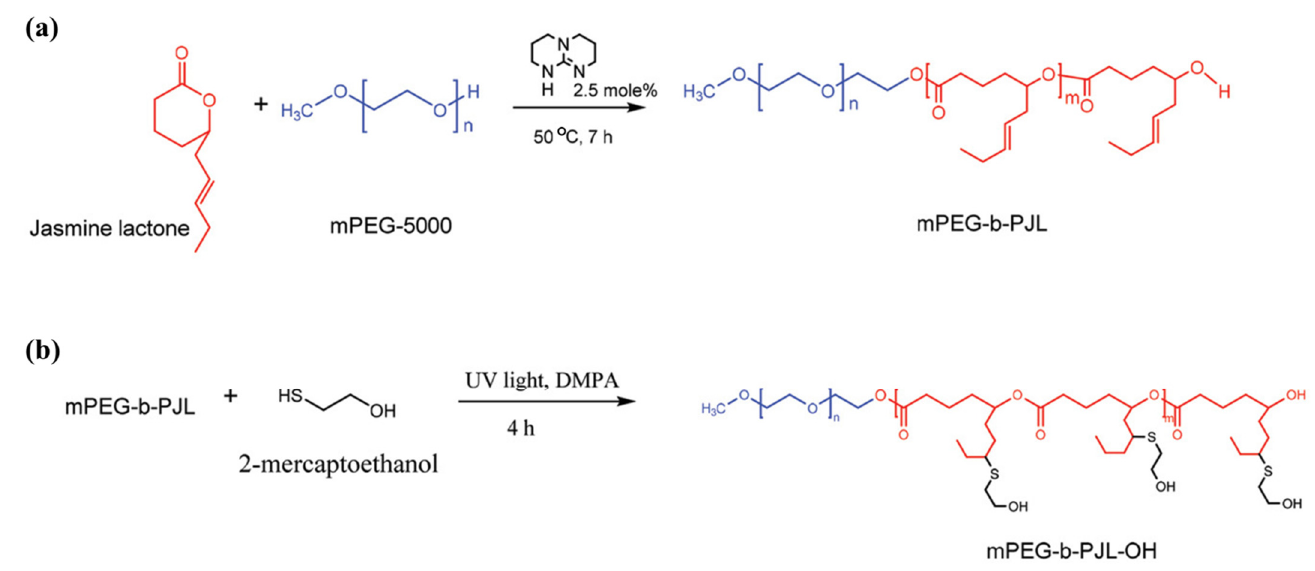
Figure 6. ( a ) Synthesis scheme of jasmine lactone block copolymer via ring-opening polymerization. ( b ) The block copolymer mPEG- b -PJL functionalization via UV-light induced thiol-ene click reaction to insert free alcohol groups (mPEG- b - PJL-OH) as represented by Bansal et al. [59].